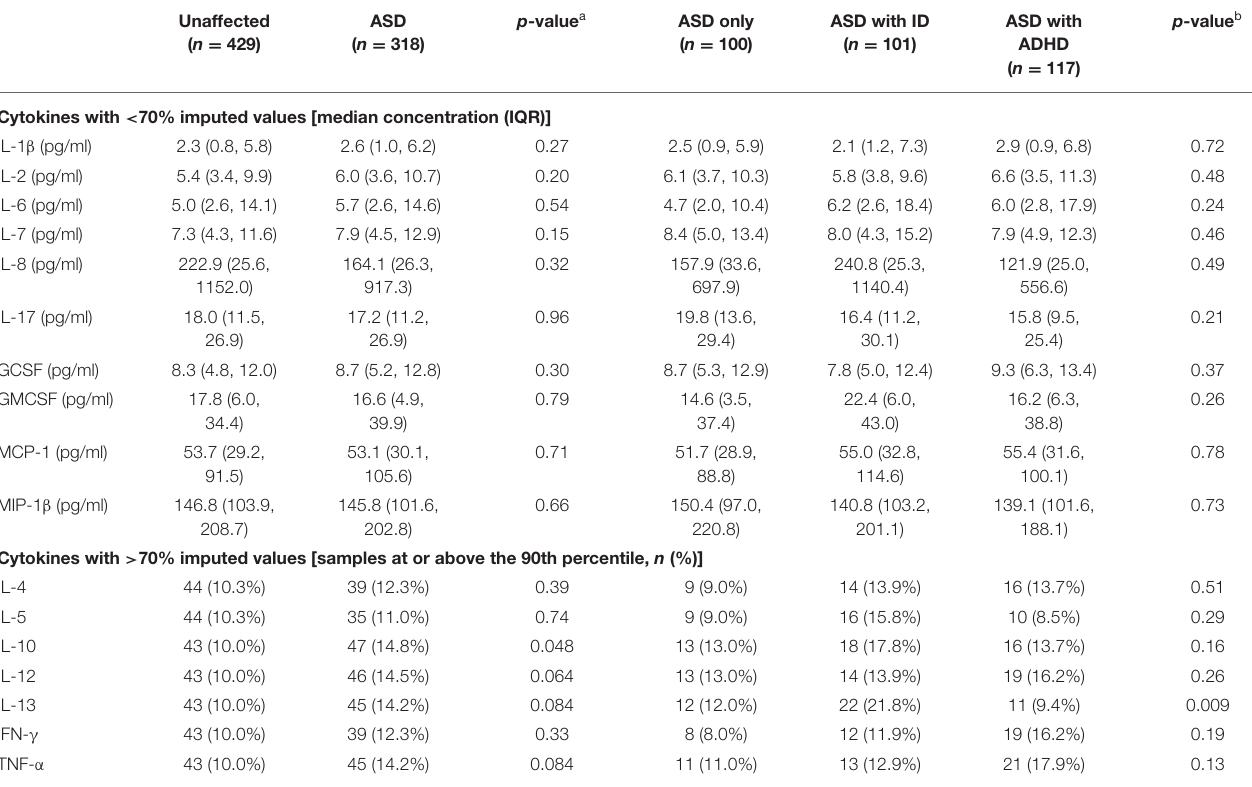
TABLE 2 | Serum sample characteristics of mothers to individuals diagnosed with ASD and mothers to unaffected individuals in the study sample. p -value a ASD only p -value b Unaffected ASD ASD with ID ASD with ( n = 429) ( n = 318) ( n = 100) ( n = 101) ADHD ( n = 117) Cytokines with < 70% imputed values [median concentration